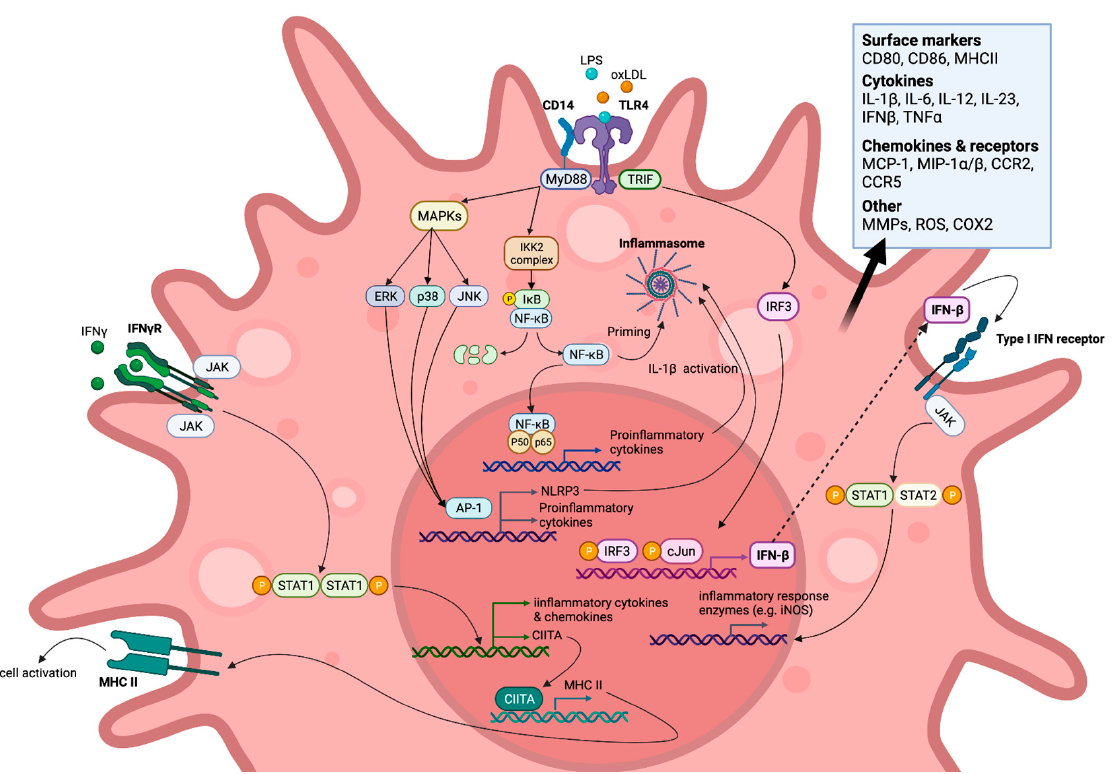
Figure 1. M1-like polarised macrophage signalling pathways (simplified) induced by toll-like receptor (TLR) and IFN- γ receptor (IFN- γ R) endogenous and exogenous agonists. Created with BioRender. com, accessed on 7 March